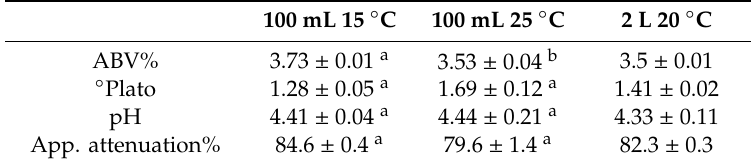
Table 1. Fermentation results for Z. flo OTA strain in 9 ◦ P wort in a 100 mL-scale and in 8 ◦ P wort in a 2 L-scale. The results are the means of two independent fermentations.